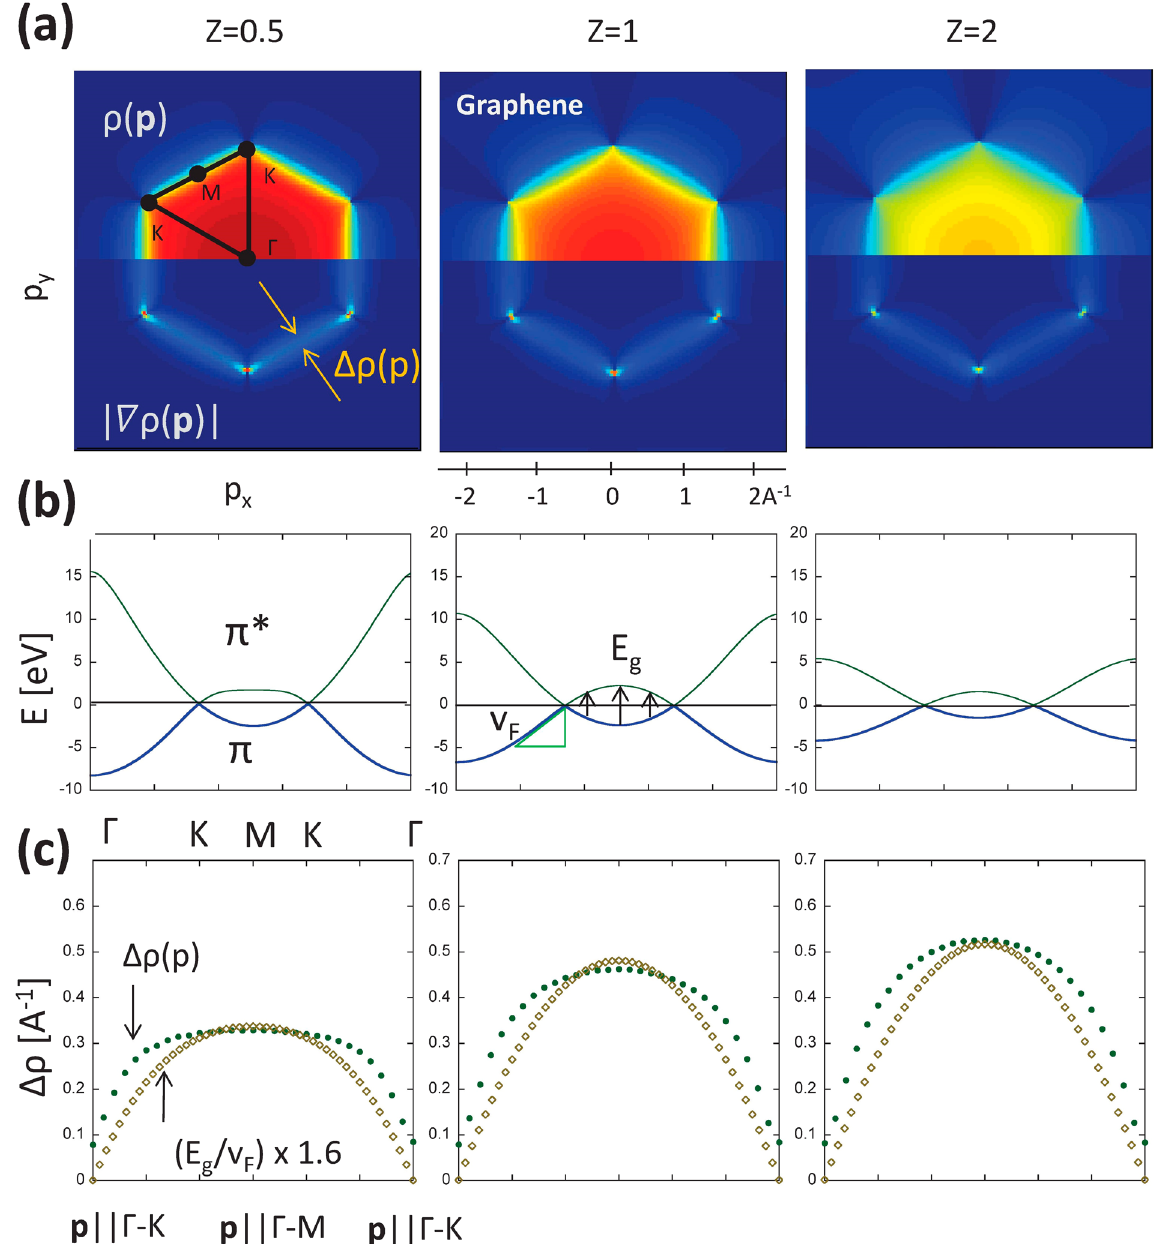
Figure 2. ( a ) EMDs and the derivatives as a function of the charge strength Z , ( b ) band dispersions, and ( c ) comparisons between the momentum broadening Δ p (FWHM in ρ ∂ ∂ p p ( )/ along the radial direction) and the gap magnitude ( E g